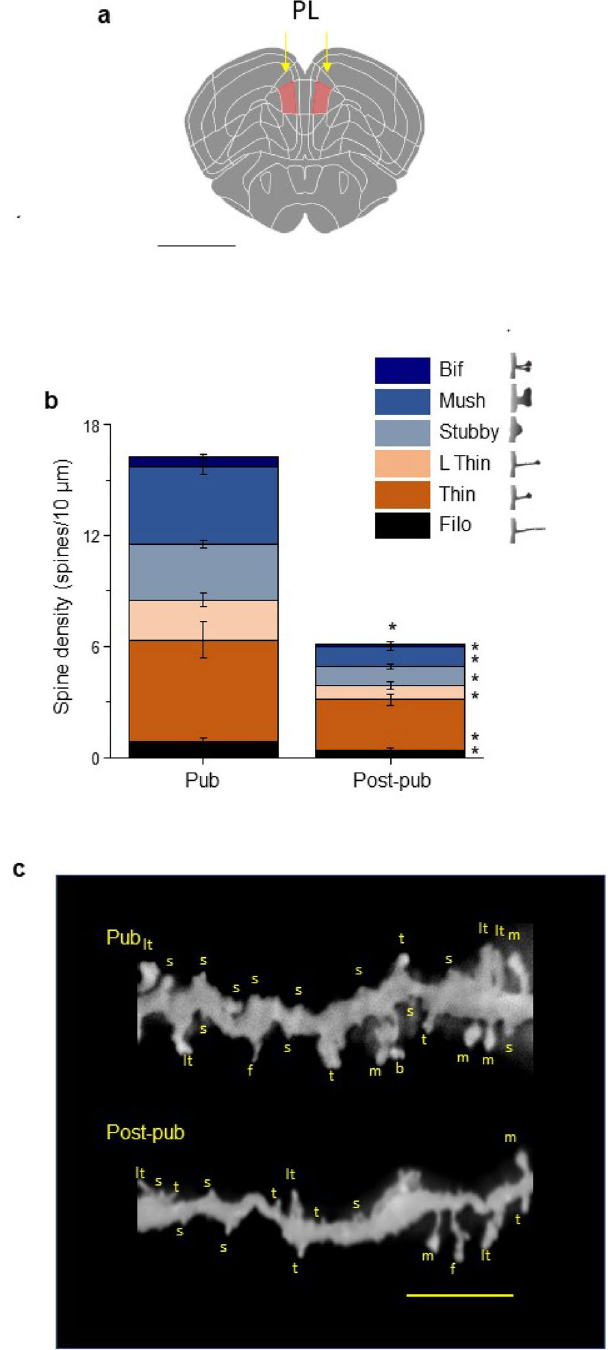
Figure 1. Spine density in layer 5 prelimbic cortex (L5 PL) of the female mouse decreases by half during adolescence: assessment of spine-types. ( a ) Schematic diagram of prelimbic cortex (PL) localization in mouse brain (pink shading, arrows). Coronal section, 2.09 mm anterior to Bregma. Scale, 1 mm. ( b ) Averaged data, spine density (#spines/10 μm) of layer 5 (L5) PL for pubertal (Pub, ~ PND 35, assessed by vaginal opening) and post-pubertal (Post-pub, PND 56) female mice. Total spines, t(20) = 6.43, *P < 0.0001; bifurcated, t(20) = 3.71, *P = 0.0014; mushroom, t(20) = 6.2, *P < 0.0001; stubby, t(20) = 6.18, *P < 0.0001; long thin, t(20) = 3.46, *P = 0.0025; thin, t(20) = 2.79, *P = 0.0114; filopodia, t(20) = 2.24, *P = 0.037. ( c ) Representative images of basal dendrites from Golgi-stained neurons, from Pub and Post-pub female mice. Spine-types: f filopodia, lt long thin, t thin, s stubby, m mushroom. Scale, 5 μm. n = 43–44 neurons, 11